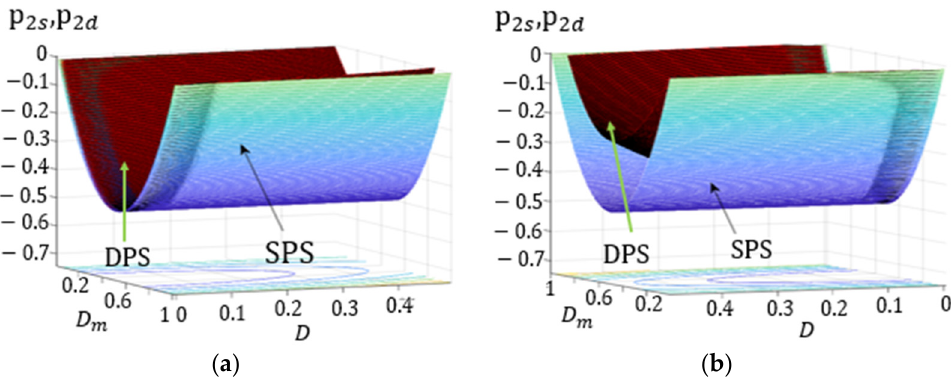
Figure 8. Unified power at port 2 for both SPS and DPS control schemes ( a ) front and ( b ) rear view.